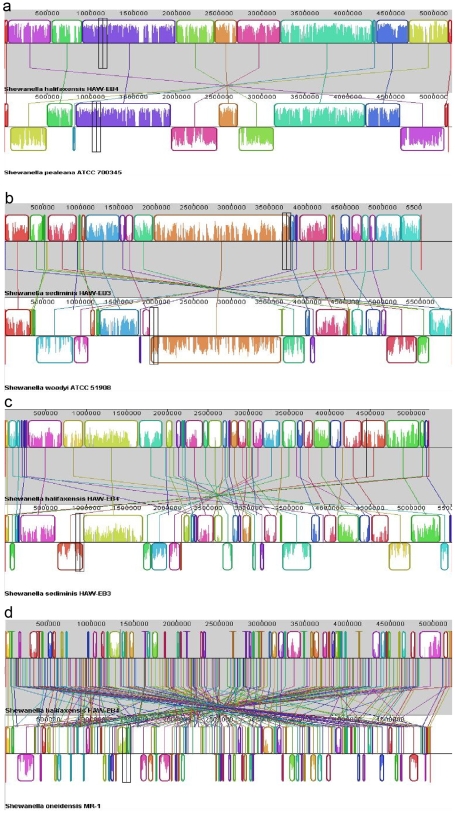
Whole-genome alignment of S.halifaxensis and S. sediminis with related Shewanella.
 Progressive-Mauve software 2.2.1 [63] was used to prepare the following alignment (minimal LCB weight, total number of LCBs). a), S. halifaxensis/S. pealeana (35774 base, 12); b) S. sediminis/S. woodyi (4207 base, 28); c) S. halifaxensis/S. sediminis (2693 base, 43); d) S. halifaxensis/S. oneidensis (118 base, 211). The same colored blocks indicate the segments, or Locally Collinear Blocks (LCBs) conserved among the two bacteria compared (linked by same line). Inverted LCBs are linked by lines crossing the mid point of chromosomes and appear on the opposite strand of the genome compared.